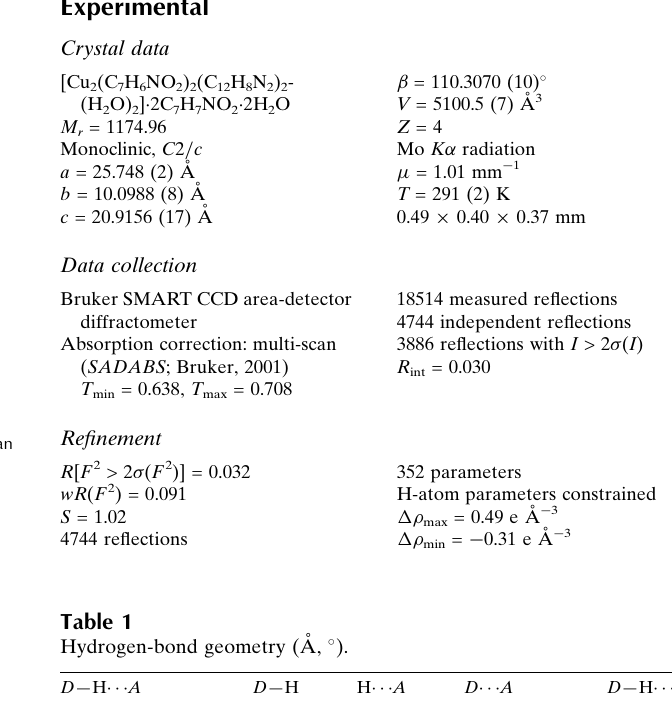
aminobenzoic acid molecules and two disordered water molecules (site occupancy factors 0.5). The Cu(II) ion adopts a distorted square-pyramidal geometry formed by two N atoms from the 1,10-phenanthroline ligand and two O atoms of the two 4-aminobenzoic acid ligands and one water O atom.